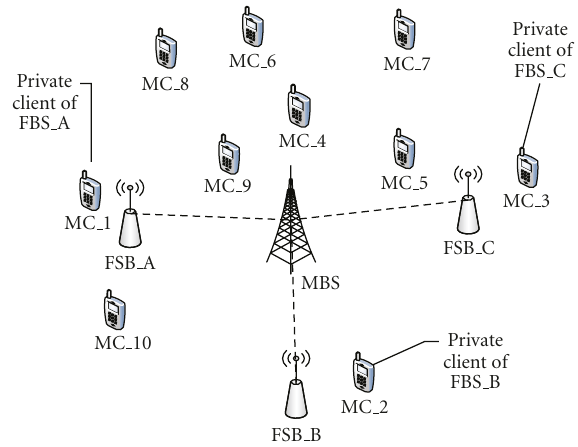
Figure 7: Simulation Scenario. In this scenario, there is 1 MBS, 3 FBSs, and 10 clients. Out of these 10 clients, 3 are private clients to an FBS. The dotted line between FBSs and MBS represents the backhaul line between them.